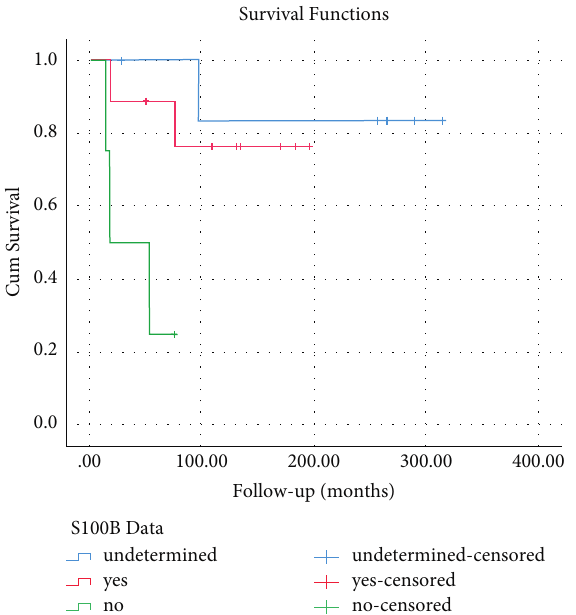
Figure 2: Kaplan–Meier survival curve based on MPNST S100B status. S100B-negative MPNSTs (green line, n � 4) were associated with a significantly lower survival than S100B-positive tumors (red line, n � 9) ( p < 0 .